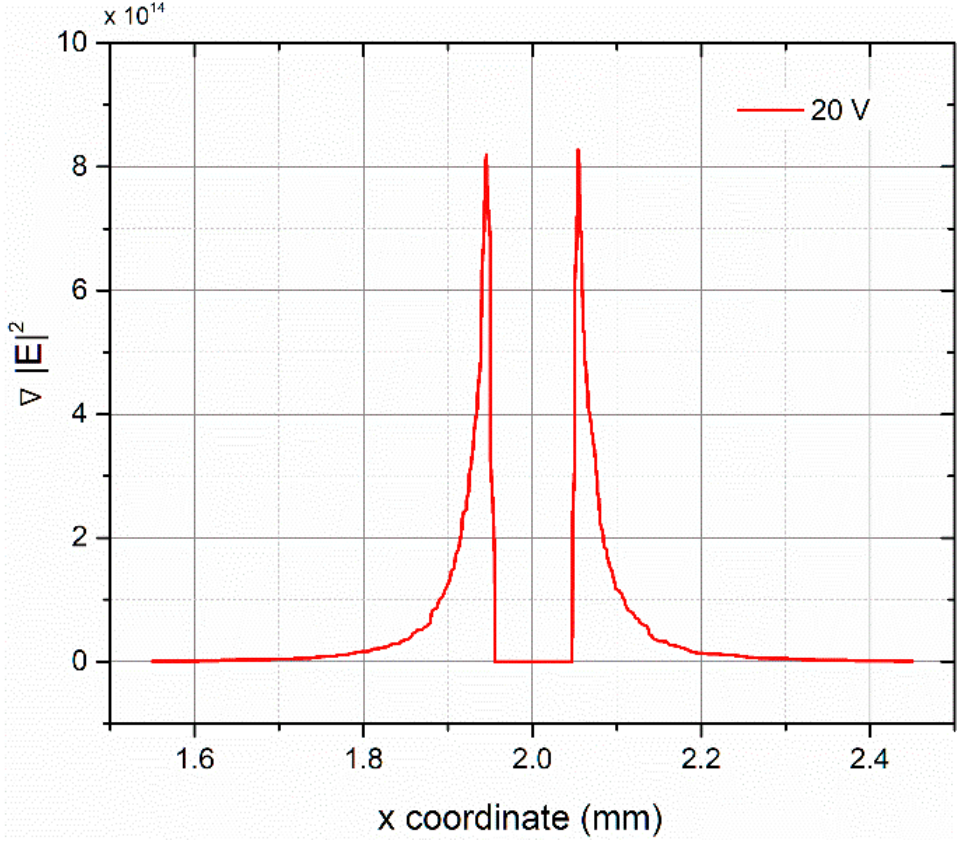
Figure 4. Spatial dependence of ∇ | E | 2 inside the cuvette .